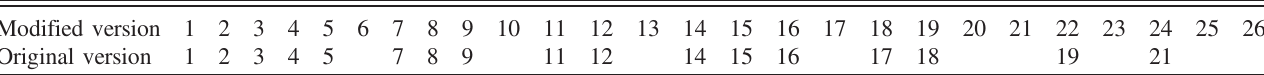
TABLE IV. Correspondence of the items in the two versions of the tests. Note that items 6, 10, 13, and 20 of the original version were removed andexchangedfor new items andthat in the modified versionwe added nine new items (items 6, 10,13, 17,20, 21, 23,25,